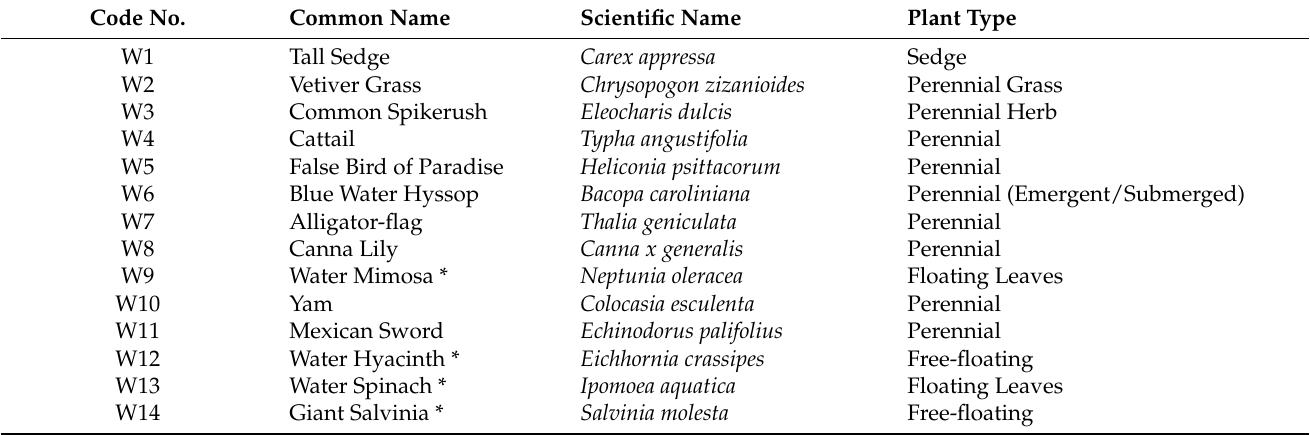
Table 1. Plant species selected for the wetland mesocosm